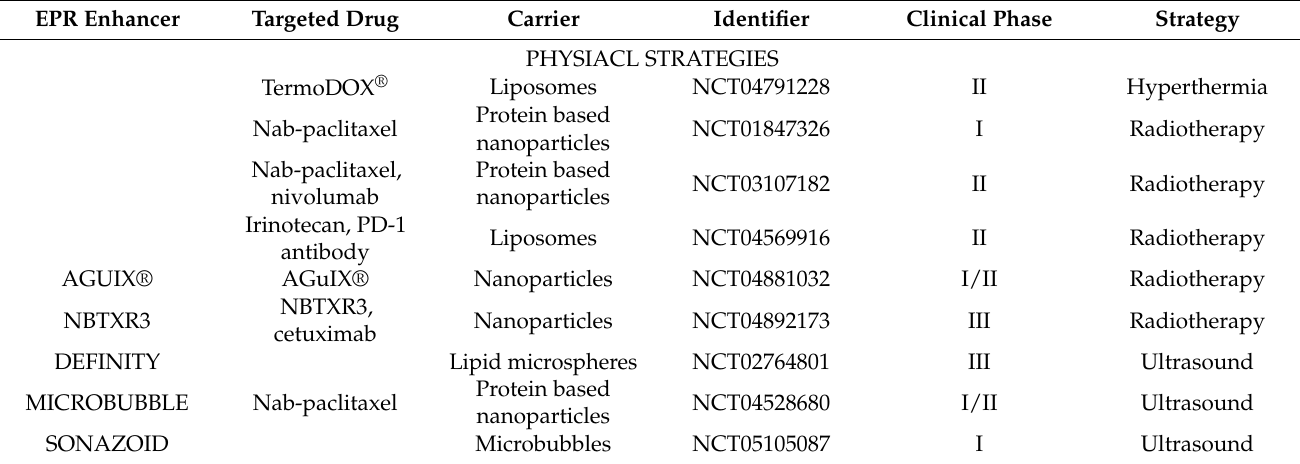
Table 3. Example of clinical trials of combination of nanomedicine with pharmacologically-based and physically-based EPR enhancing strategies. Adapted from [23]. Copyright (2023), with permission from